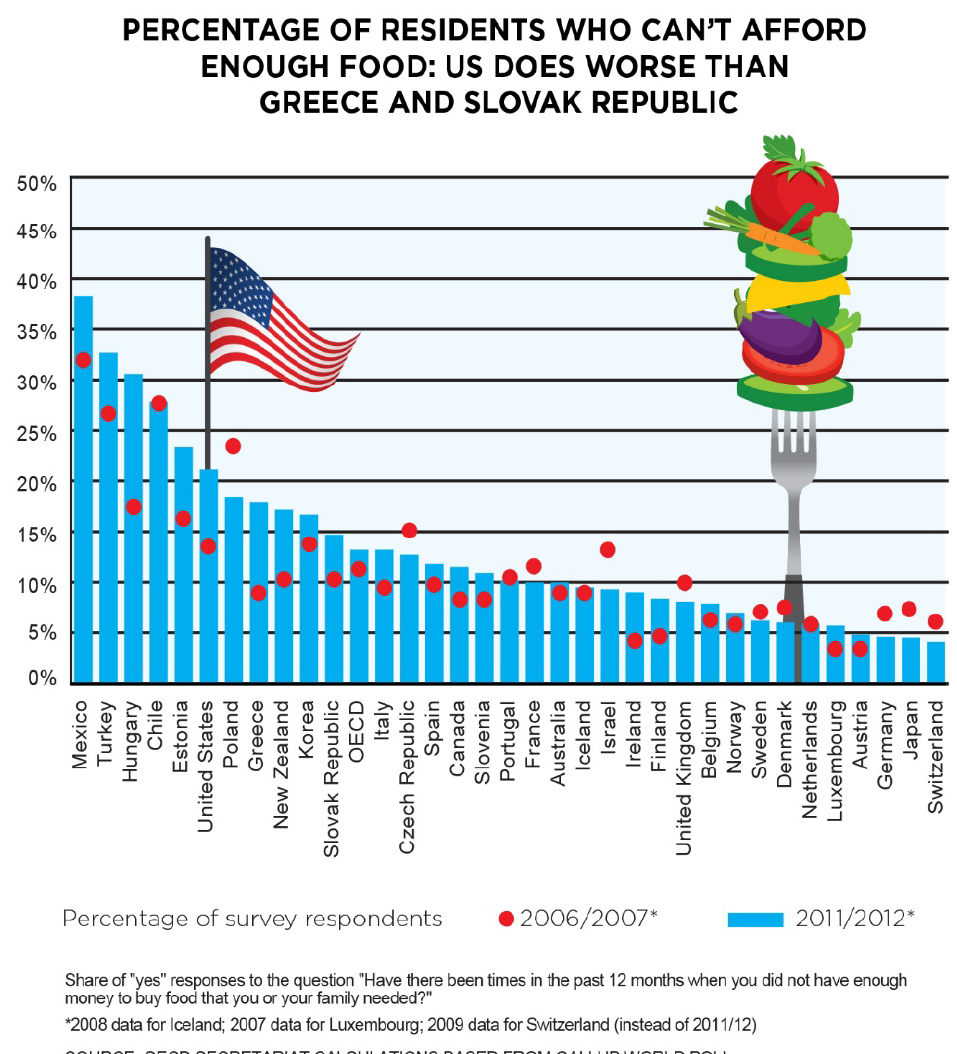
Figure 3. Comparison of food affordability in OECD countries. The percentage of the US population unable to afford an adequate supply of food was higher than most other OECD countries. Graph created by Hunger Free America using publicly available OECD data [17].